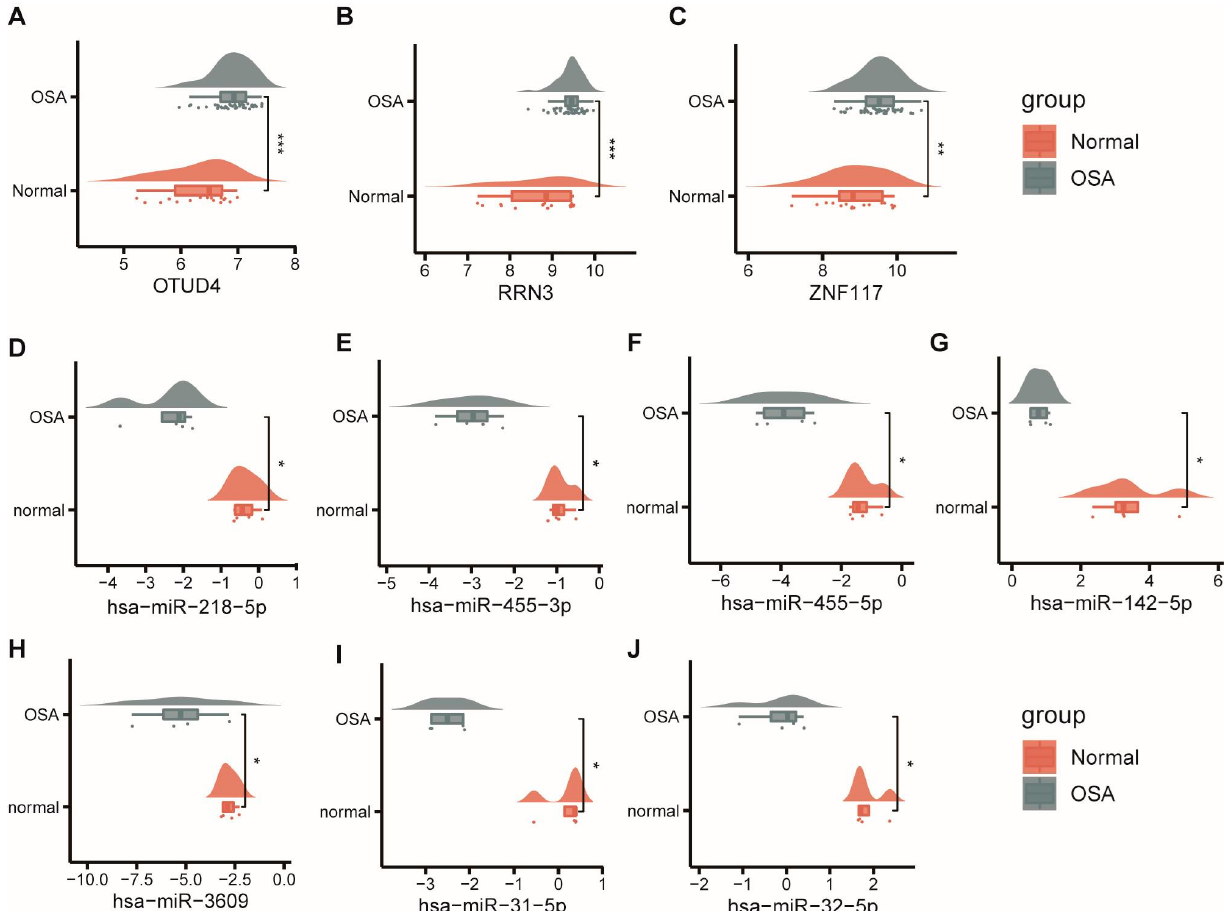
Figure 7. Expression analysis of the hub ceRNA networks. ( A – J ) The expression pattern of the nodes in the key ceRNA networks in OSA patients and normal controls. Mann–Whitney U test. * p < 0.05; ** p < 0.01; *** p <